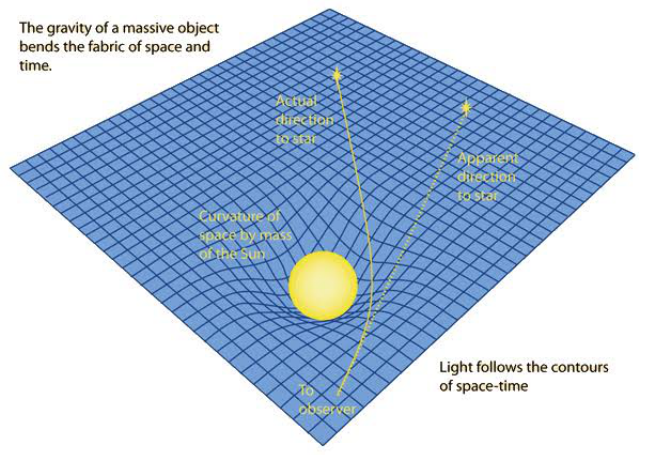
Figure 7. Curved spacetime around the Sun-spacetime in general